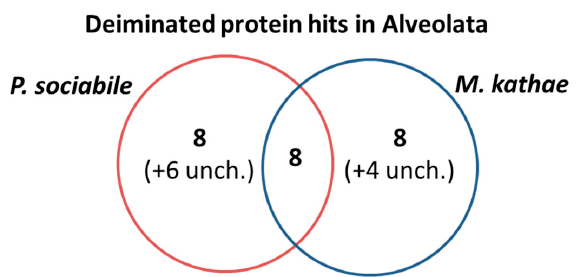
Figure 6. Deiminated protein hits identified in P. sociabile and M. kathae . Overall 8 deimination hits overlapped with the two Alveolata under study, while 8 hits were specific to P. sociabile (with fur- ther 6 uncharacterised hits), and 8 hits were specific to M. kathae (with further 4 uncharacterised hits). See Tables 1 and 2 for the individual hits.